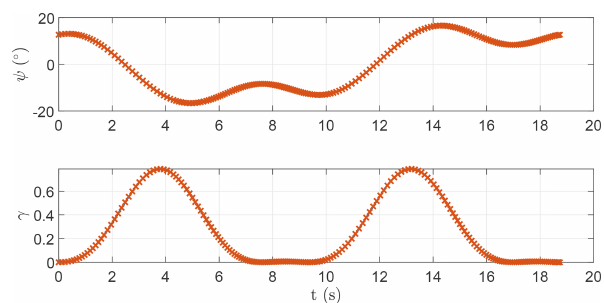
Figure B4. Time series of the control inputs provided to the har- monic balance method and the time integration scheme for a figure- of-eight-shaped